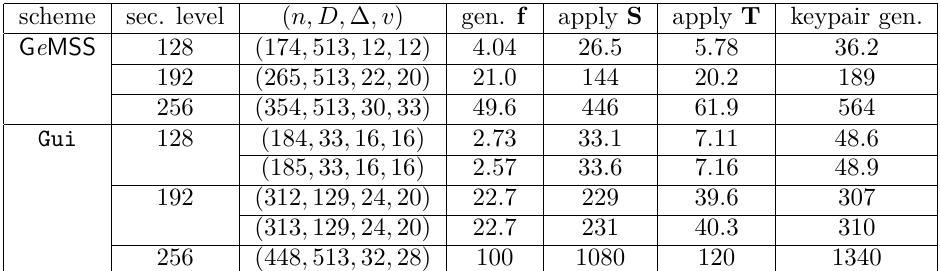
Table 22: Number of mega cycles for main steps of keypair generations with MQsoft . We use a Skylake processor